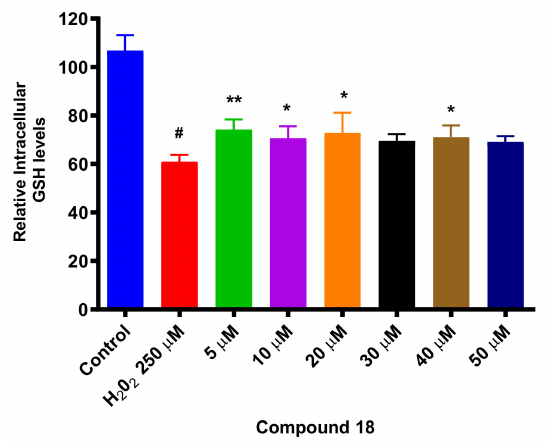
Figure 24. Effect of compound 18 on intracellular GSH levels in SH-SY5Y cells exposed for 24 h to oxidative stress pressure with 250 µ M H 2 O 2 . Cells were treated with derivative 18 at 5, 10, 20, 30, 40, and 50 µ M for 24 h prior to exposure to H 2 O 2 . Data are presented as the Mean ± SD of four independent experiments carried out in triplicate. # p < 0.001 vs. vehicle-treated control. * p < 0.05, ** p < 0.01 vs. cells treated only with H 2 O 2